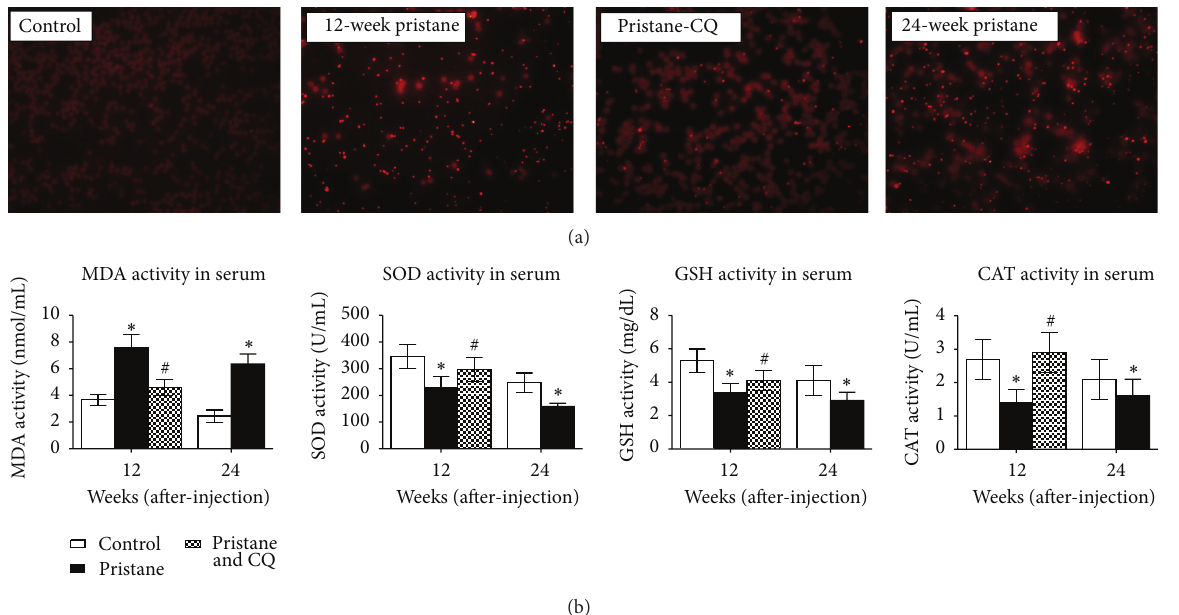
Figure 4: Effects of chloroquine on oxidative stress induced by pristane. Pristane increased the content of superoxide (red, DHE stain) and MDA and decreased the levels of SOD, GSH, and CAT, which could be ameliorated by coadministration of pristane and CQ. Original magnification × 400. CQ: chloroquine; MDA: malondialdehyde; SOD: superoxide dismutase; GSH: glutathione; CAT: catalase. ∗ 𝑃 < 0.05 versus the corresponding control mice, # 𝑃 < 0.05 versus mice exposure to pristane for 12